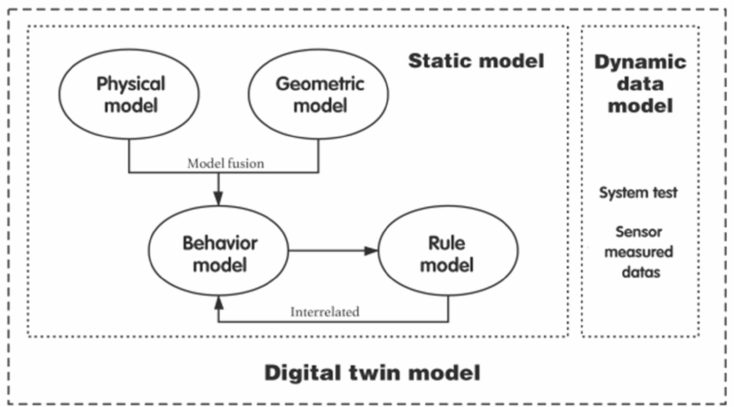
Figure 4. System Construction